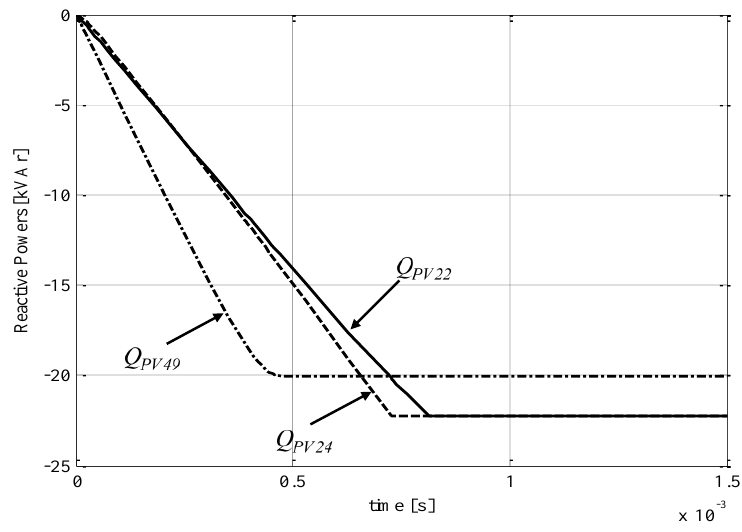
Figure 9. Time domain behavior of reactive power outputs of the PV-inverters connected at the buses #22, 24, and 49.